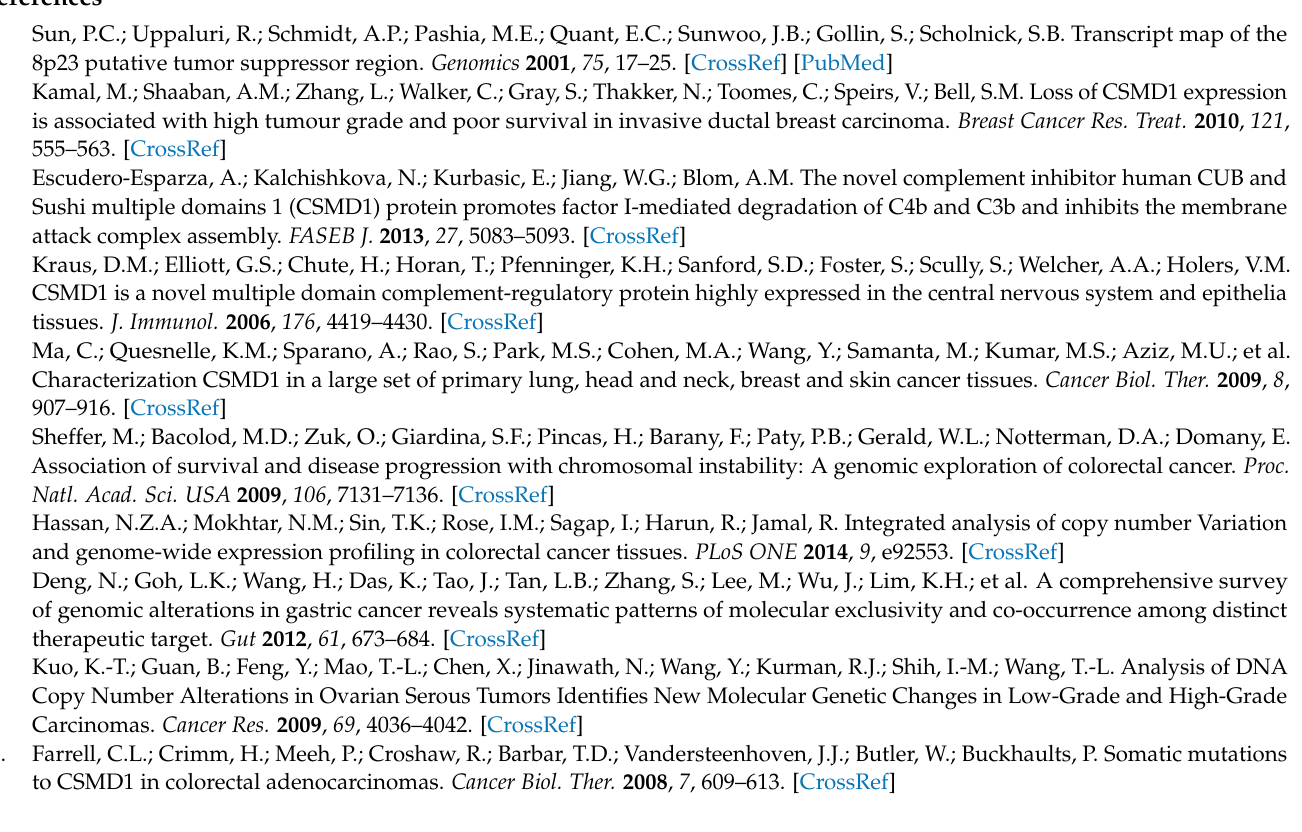
Table S3: Details of somatic alterations on CSMD1 based on SNP array in 56 ESCC cases. Table S4: CSMD1 gene expression in ESCC cases, using qRT-PCR. Table S5: Expression of miRNA targets for CSMD1 in 56 ESCC cases. Table S6: (a) Significant correlations between somatic CN alterations and expression of CSMD1 in ESCC. (b) Significant correlations between somatic CN alterations and expression of CSMD1 target mRNAs in ESCC. (c) Significant correlations between expressions of CSMD1 and its target miRNAs in ESCC. Table S7: (a) CSMD1 expression in ESCC patients with